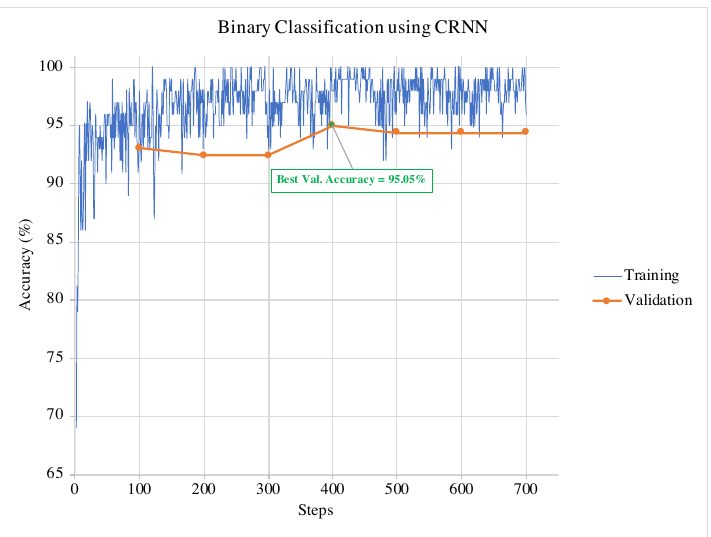
Figure 5. Example of the training and validation phases of CRNN for binary classification in a single run.